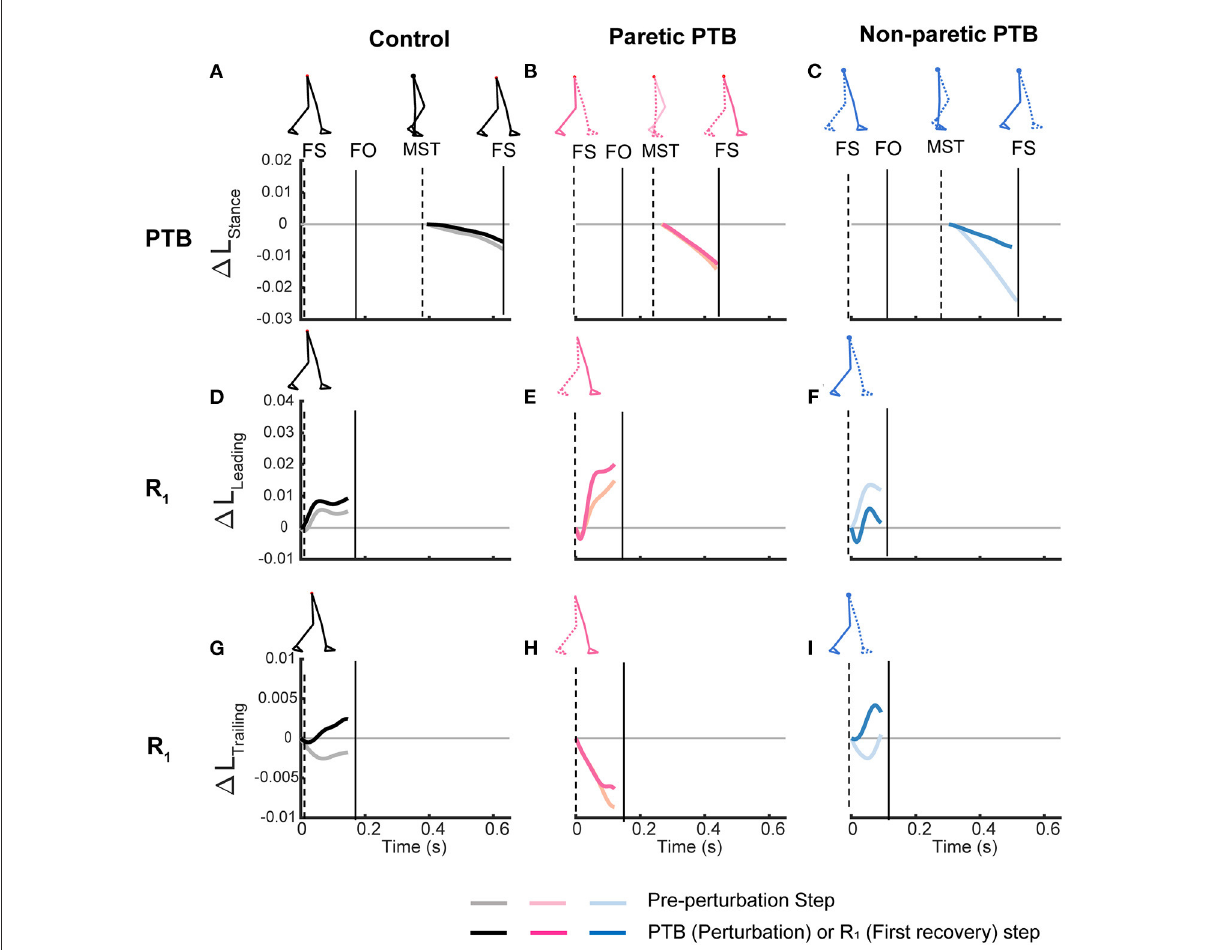
FIGURE5 Time series trajectories of the PTB 1 L Stance (A–C) , R 1 1 L Leading (D–F) , R 1 1 L Trailing (G–I) , and the corresponding trajectories during the pre-perturbation step for a representative neurotypical perturbation (left) , one paretic perturbation (middle) , and one non-paretic perturbation (right) . Pre-perturbation trajectories are shown in lighter colors while perturbation and recovery traces are shown in darker colors. The first, second, and third rows correspond to PTB 1 L Stance , R 1 1 L Leading , and R 1 1 L Trailing , respectively. FS, Foot strike, FO, Foot-off, MST, Midstance. Vertical lines indicate gait events with the dashed line corresponding to the ipsilateral limb while the solid line indicates the contralateral